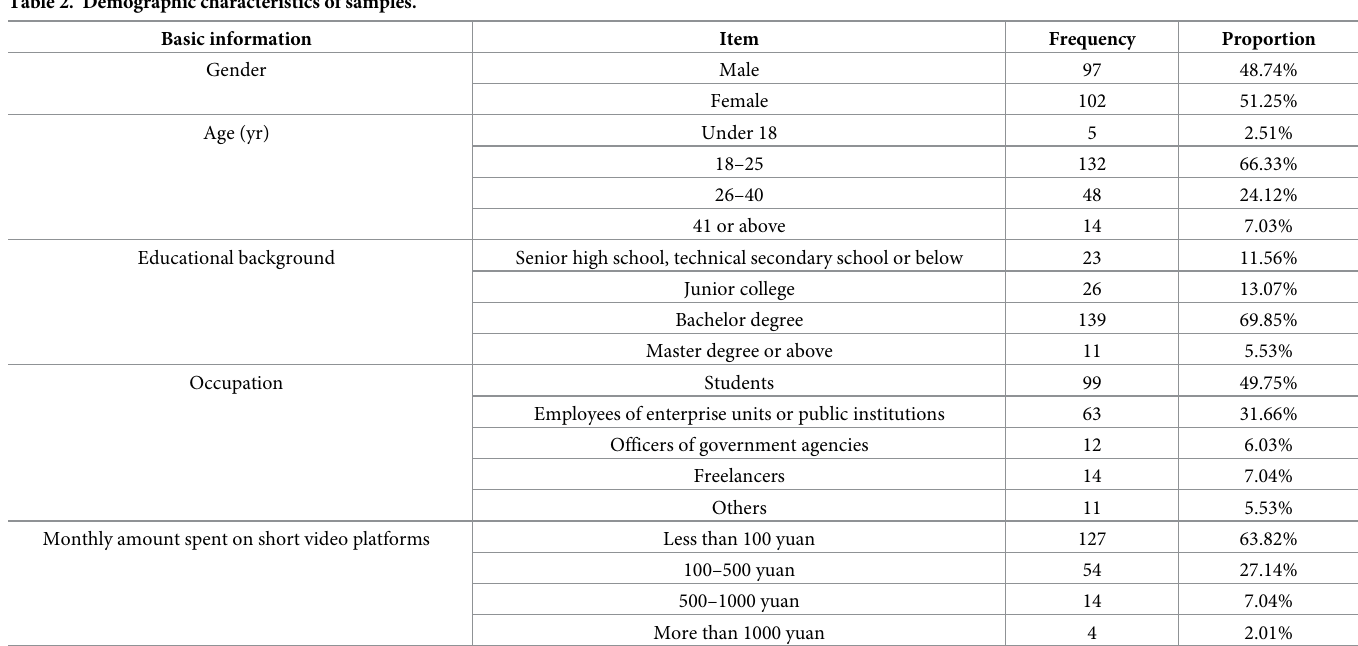
Table 2. Demographic characteristics of samples.